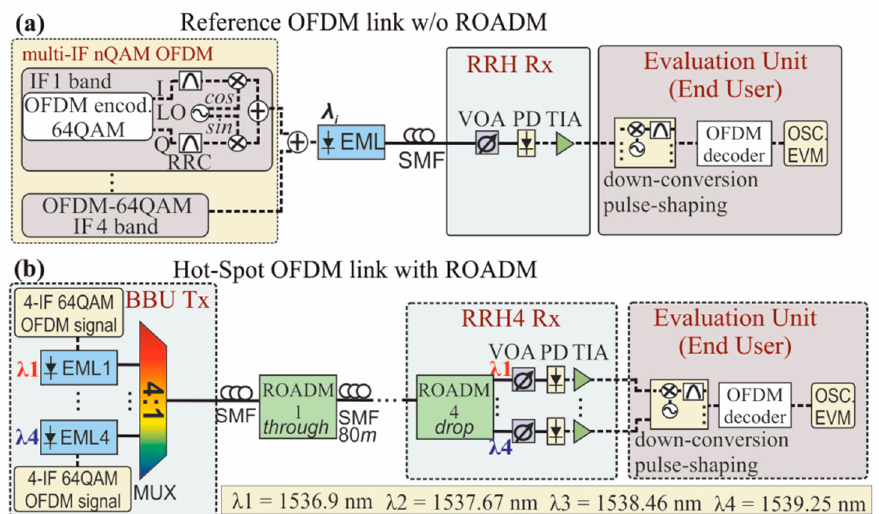
Figure 6. Simulated setup of the IFoF optical fronthaul using OFDM, for ( a ) the reference link employed for the transmission of a single λ and ( b ) the hotspot link comprising the optical WDM Tx at the BBU and the ROADM network at the RRHs’ side.